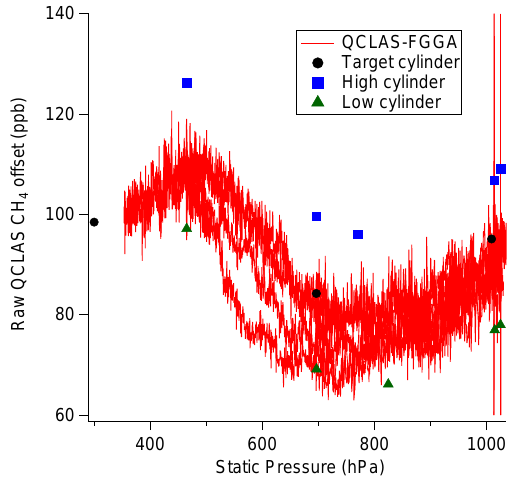
Figure 6. The offset between the raw QCLAS CH 4 measurements and both the corresponding calibrated FGGA data and the known contents of the target, high and low calibration cylinders during flight B848, shown as a function of static pressure. Although the absolute magnitude of the offset differs for these four different mea- surements, the same broadly repeatable pattern is exhibited by each of them.